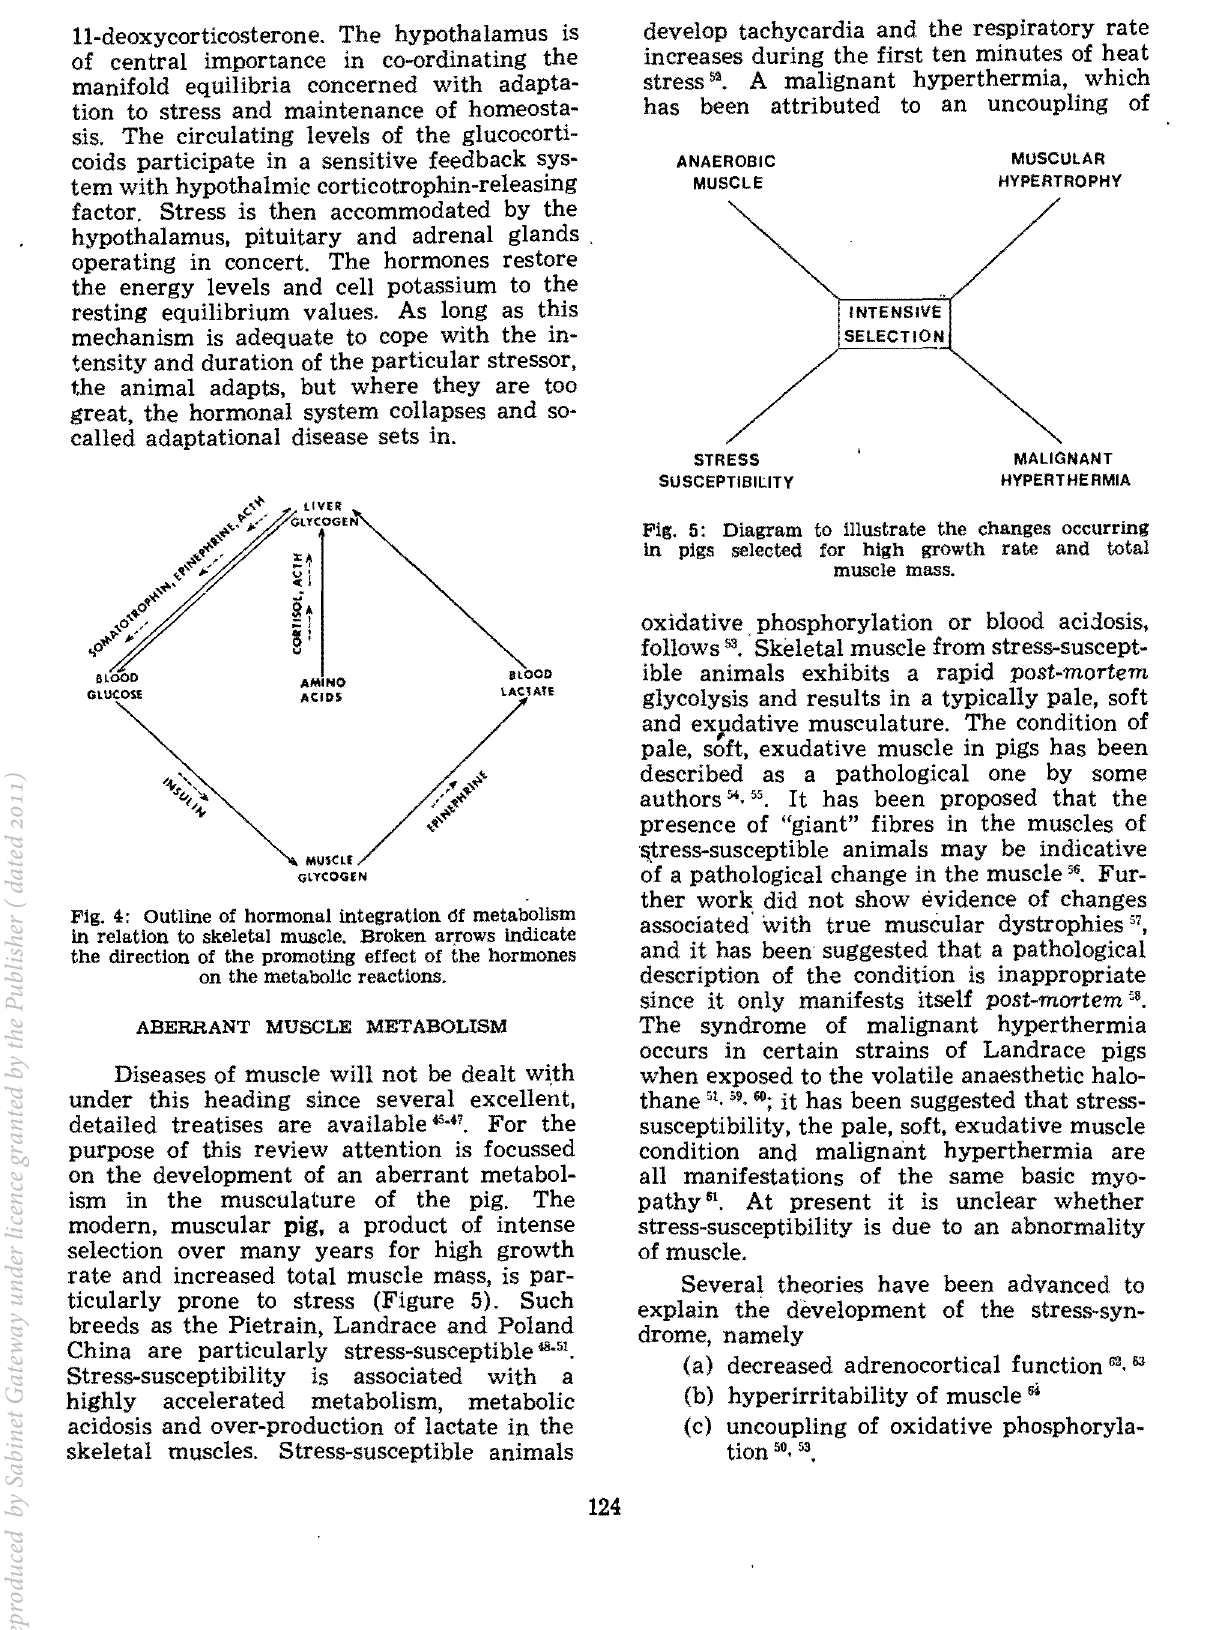
Fig. 5: Diagram to illustrate the changes occurring in pigs selected for high growth rate and total muscle